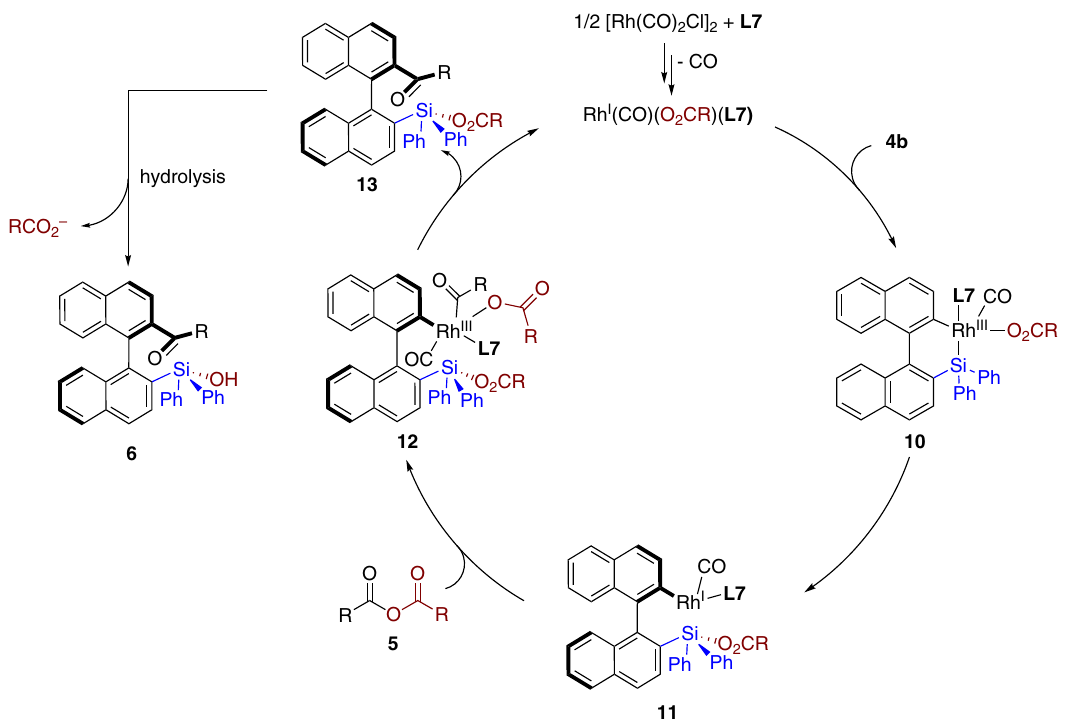
Fig. 7 Possible mechanism. The oxidative addition of in situ formed Rh(I) catalyst with 4b gives 10 . Subsequent reductive elimination forms optically active biaryl intermediate 11 . The second oxidation addition of 11 with acid anhydride 5 gives 12 , which regenerates Rh(I) catalyst and compound 6 via reductive elimination, followed by